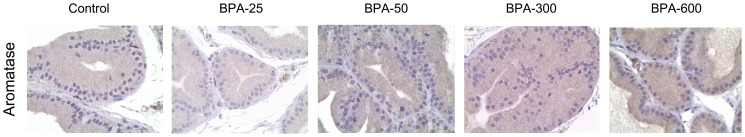
Immunohistochemical staining of aromatase in prostate of control and BPA-treated rats at doses of 25, 50, 300, or 600 µg/Kg/d for 4 days.Magnification ×400.